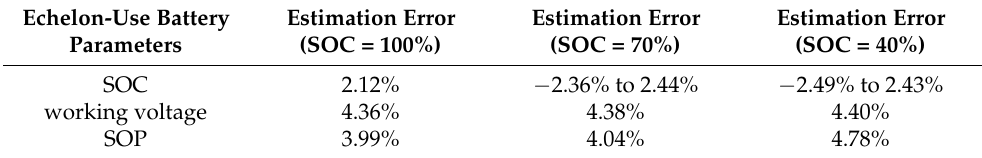
Table 2. Estimation error of the echelon-use battery parameters. Echelon-Use